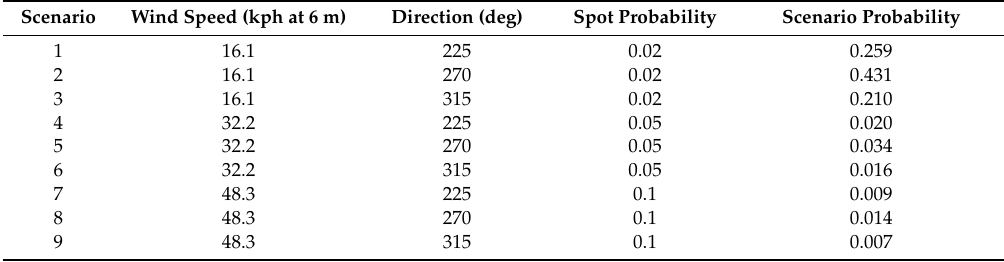
Table 1. Fire scenarios used to simulate fires in RANDIG. Burn duration was set to 240 min and fuel moisture was held constant at the 3rd percentile of the historical